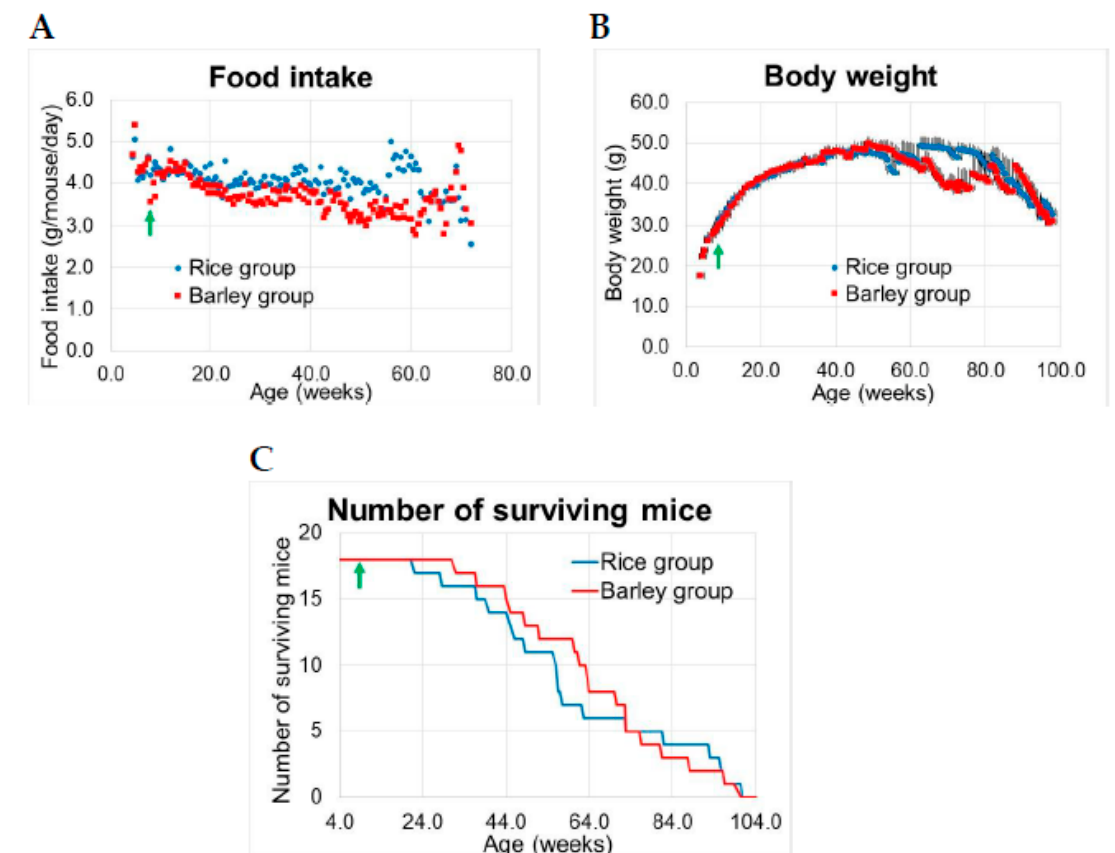
Figure 2. Food consumption, body weight, and number of surviving senescence-accelerated mouse-prone 8 (SAMP8) mice consuming rice or barley diets during the lifespan: ( A ) food consumption (g / mouse / day), ( B ) body weight (g), mean ± SE, ( C ) number of surviving mice. Green arrow; start timing of mild high-fat diets.